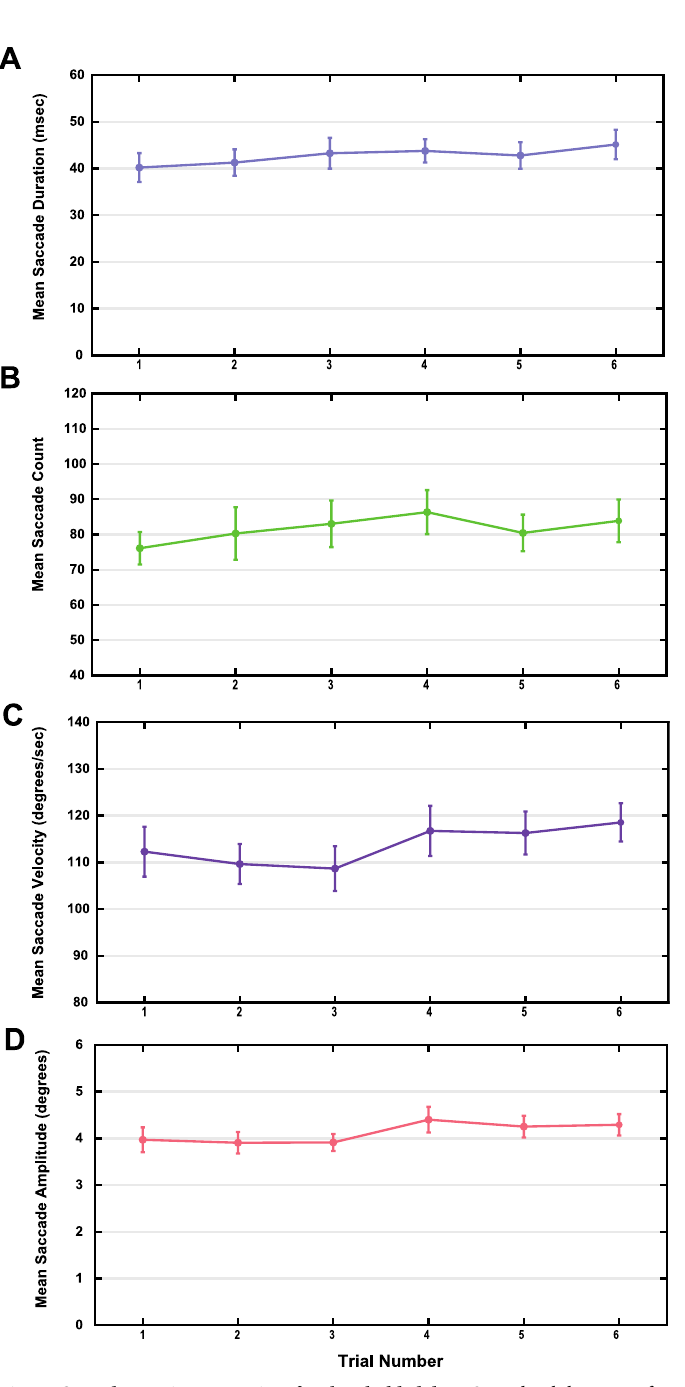
Fig 12. Saccade metrics across time for thresholded data. Saccades did not significantly change in duration (A), count (B), mean velocity (C), or amplitude (D) across time. Data presented as mean +/- 1 SEM.